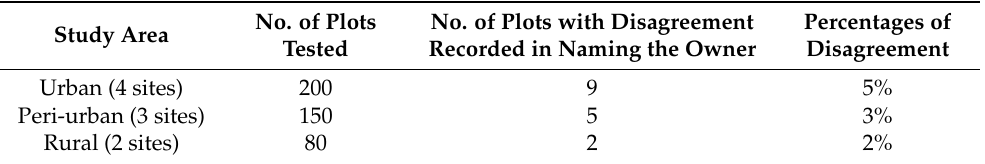
Table 3. Verifying ownership data by crowdsource